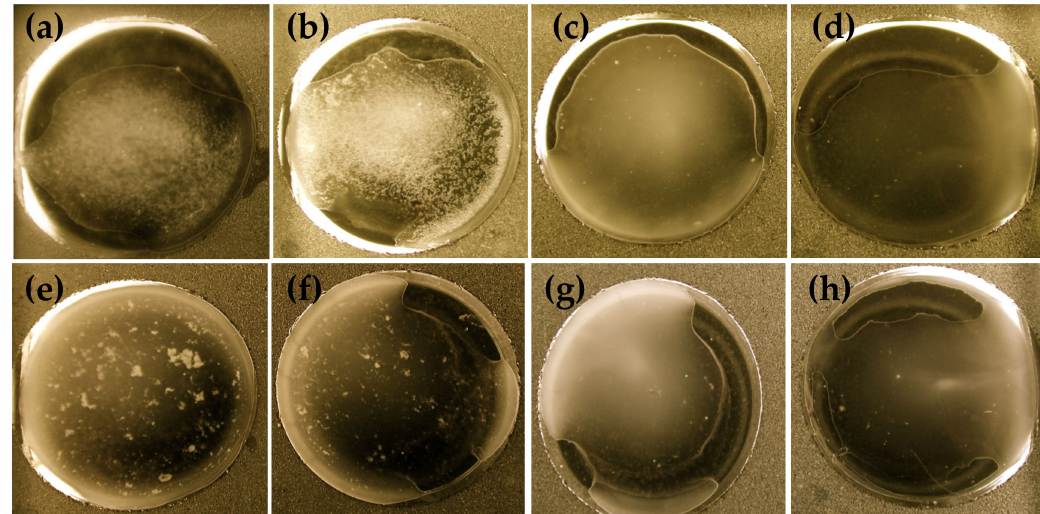
Figure 3. Agglutination of F4 + and F18 + E. coli by recombinant L. lactis displaying surface anti-F4 + and anti-F18 + Nb, respectively, anchored on the cell wall by protein A. Top panel: ( a ) positive agglutination of F4 + E. coli strain C1065-79 and ( b ) F4 + E. coli strains C544-79 by anti-F4 L. lactis (pEXP368; α F4 V4 on long protein A anchor). In the control tests, ( c ) no agglutination was seen between E. coli C1065-79 and control L. lactis (pEXP362; α F18 NbFedF6 on long anchor ProtA) or ( d ) C1065-79 in PBS. Bottom panel: agglutination of F18 + E. coli strain by anti-F18 Lactococcus strains, ( e ) F18 + E. coli K514 ∆ fim (pIH120) that contain the gene cluster for F18 fimbriae biogenesis [8] and L. lactis (pEXP362), ( f ) F18 + E. coli K514 ∆ fim (pIH120) and L. lactis (pEXP364 (NbFedF7 on long protein anchor). In the control tests, no agglutination is seen between ( g ) K514 ∆ fim (pIH120) and non-F18 L. lactis (pEXP368, α F4 V4) or ( h ) K514 ∆ fim (pIH120) in